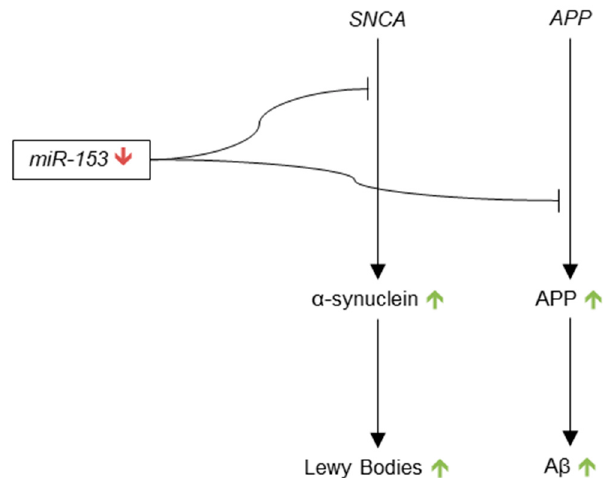
Figure 10. Regulation by miR-153. miR-153 inhibits the translation of α -synuclein and amyloid precursor protein (APP). The red arrow indicates that miR-153 expression is decreased in AD brain. The green arrows denote the hypothetically increased levels of α -synuclein, Lewy bodies, APP, and A β resulting from miR-153 downregulation.